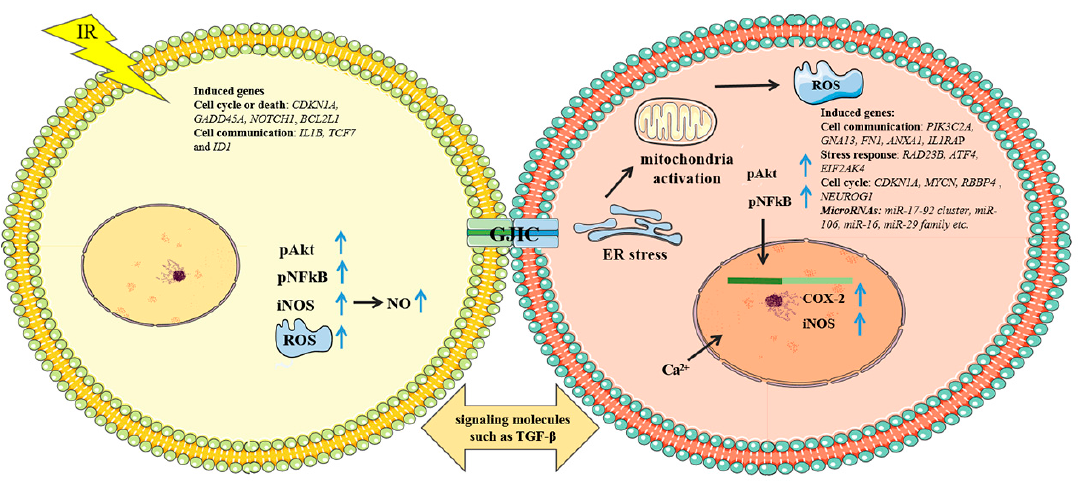
Figure 1. Regulatory factors involved in bystander effects induced by microbeam irradiation. Please refer to main text for detailed information.